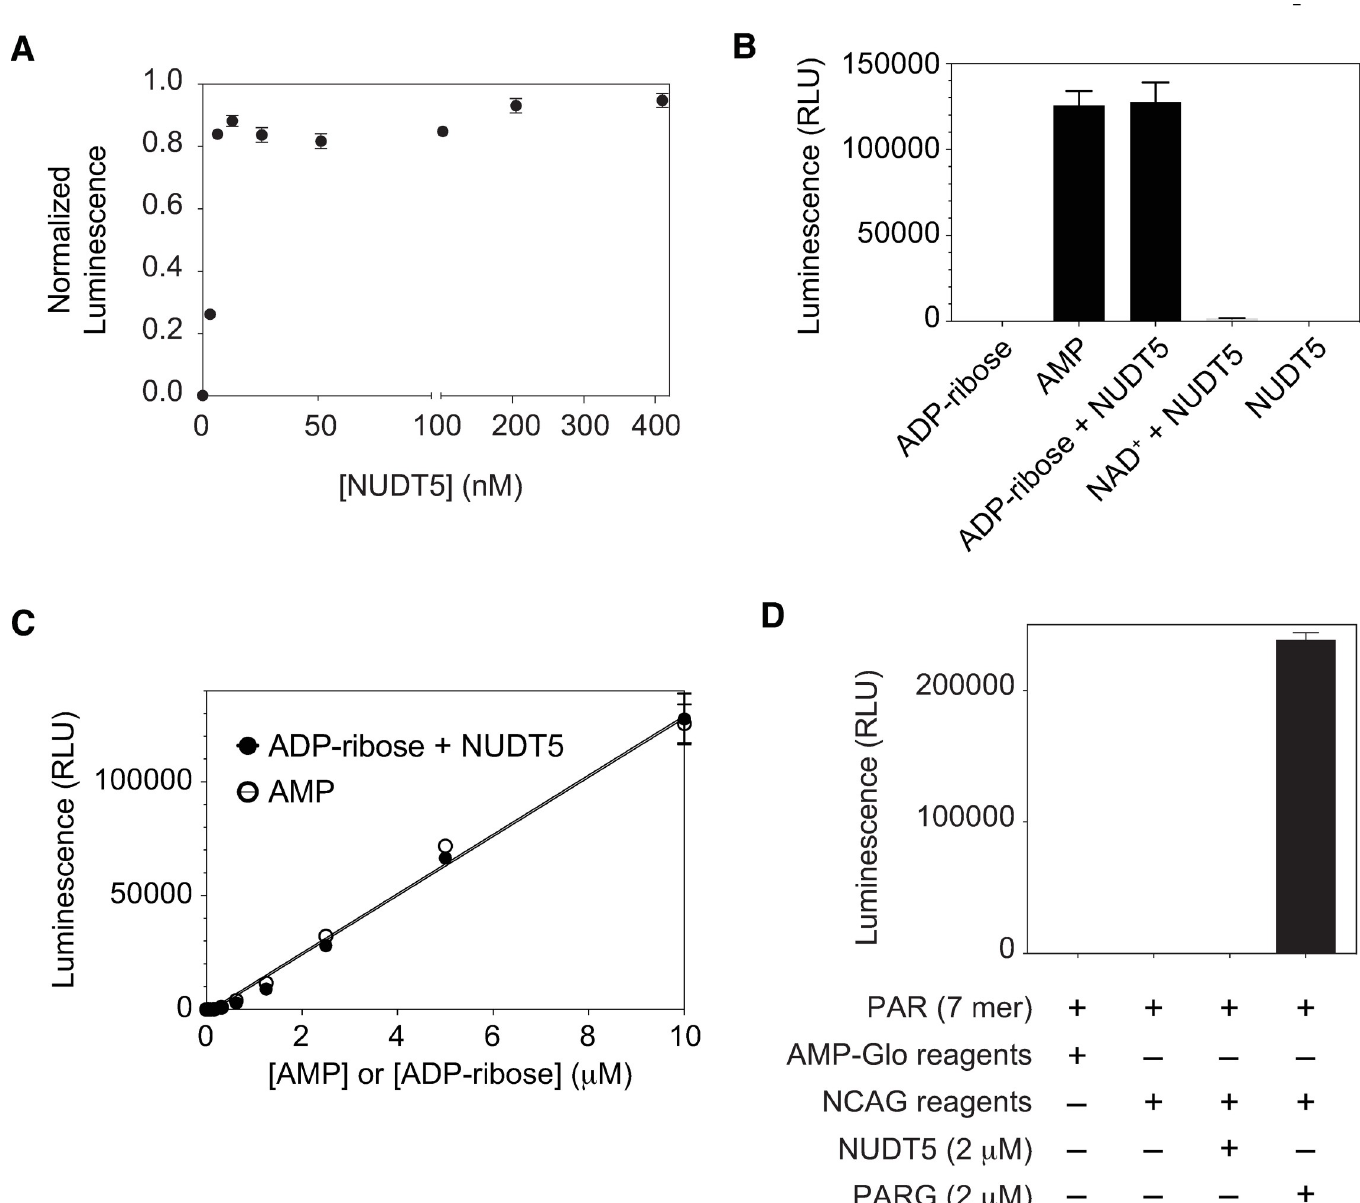
Fig 3. The NUDT5-coupled AMP-Glo (NCAG) assay effectively and selectively monitors the protein-free mono-ADP-ribose. A. NUDT5 titration against 10 μ M ADPR. The luminescence signals from NUDT5-mediated digestion of ADPR are normalized with respect to that from 10 μ M AMP. B. Comparison of NCAG luminescence signals from different types of substrates. Experiments were done using 10 μ M of all substrates and 400 nM NUDT5. C. A standard curve of ADPR and AMP in the NCAG assay using 400 nM NUDT5. Standard deviations from triplicates were calculated for all NCAG assays and are shown as error bars. D. NUDT5 is unable to cleave protein-free poly(ADP-ribose) chains. Isolated PAR chains (7 mer, 38 μ M) were assayed using the NCAG assay after NUDT5 (2 μ M) and PARG (2 μ M) digestions. A control reaction with the basic NCAG reagents (AMP-Glo reagents and 400 nM NUDT5) did not show signal increase in comparison to that with only AMP-Glo reagents. The AMP-Glo-only readout was used for background subtraction in panel D. https://doi.org/10.1371/journal.pone.0254022.g003 ADP-ribosyl transferases, such as PARPs, use β -NAD + as a substrate. Since NAD + has a similar structure to ADPR, this raises the possibility that unreacted residual β -NAD + in ADP- ribosylated substrates may generate high background signal. This off-target effect against NAD + would be an important factor in our NCAG assay, as a complete removal of NAD +